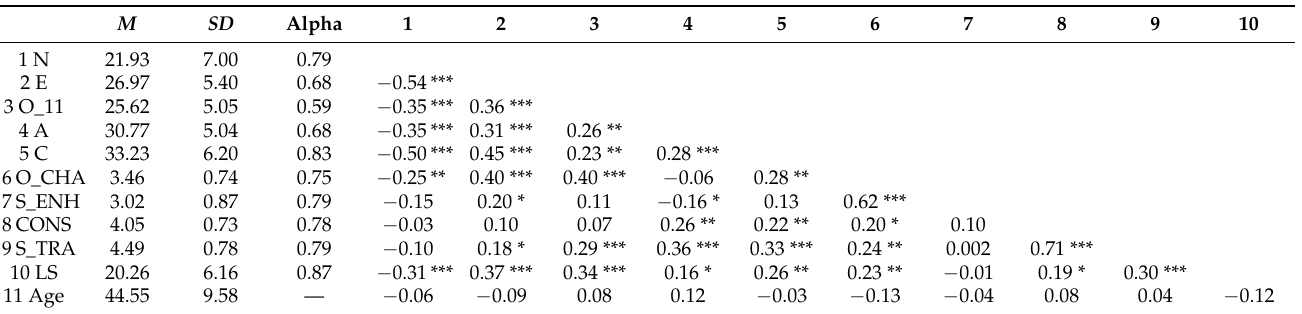
Table 1. Means, standard deviations, and reliability (Cronbach’s α ) of the variables and the intercor- relations between traits, meta-values, LS, and age ( N =